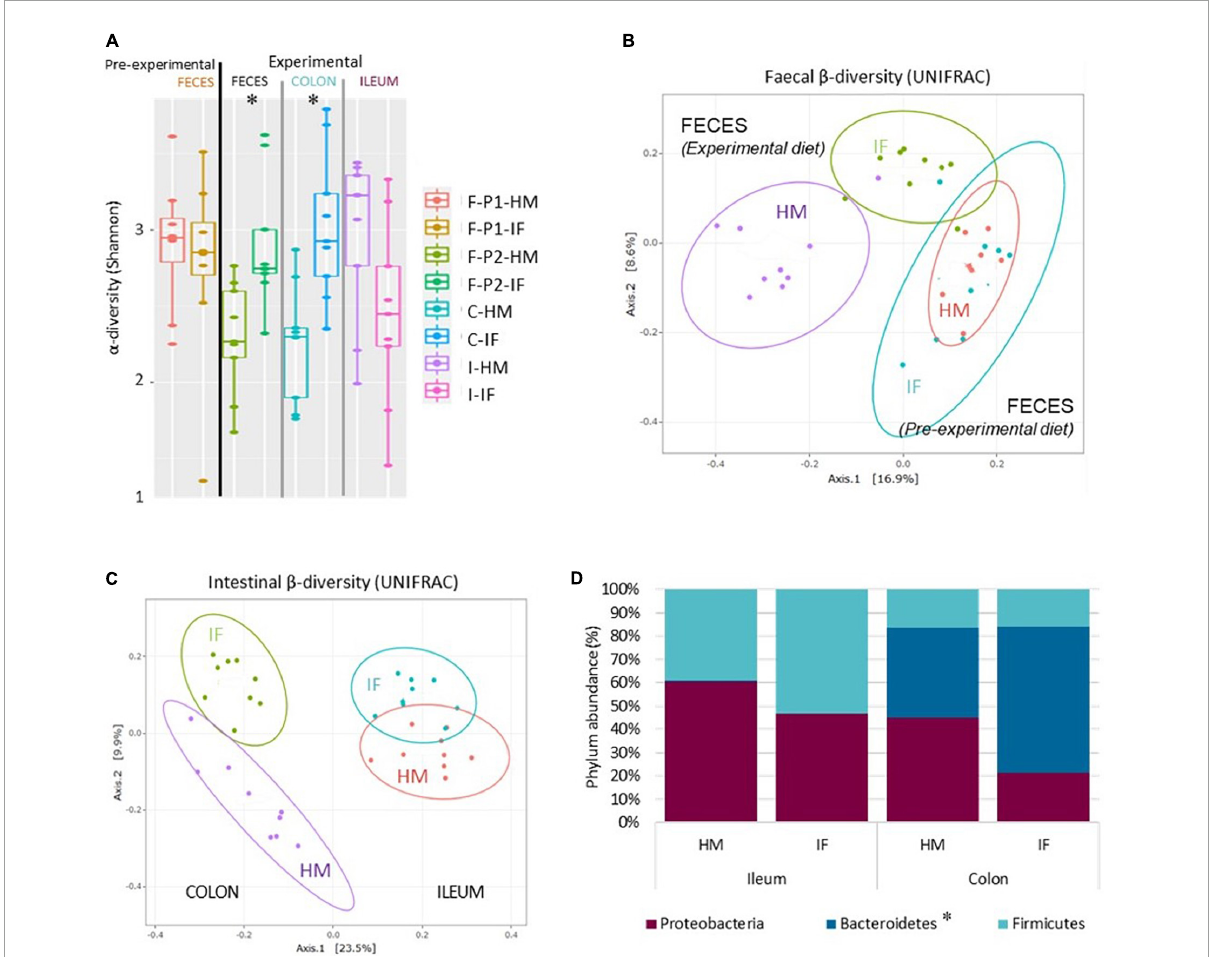
FIGURE1 Microbiota composition and diversity. (A) Microbial α -diversity (Standardized Shannon Index) in feces (F-), and colonic (C-) and ileal (I-) digesta of HM- and IF-fed piglets during the adaptation period (P1, bovine milk) and the experimental (HM or IF) period (P2). (B) Microbial fecal β -diversity (Unifrac index) of HM- and IF-fed piglets during the adaptation (blue and orange ovals) and the experimental (purple and green ovals) periods. (C) Microbial ileal and colonic β -diversity (Unifrac Index) during the experimental period. (D) Most abundant phyla in ileal and colonic digesta of HM- and IF-fed piglet (abundance > 0.05%), ∗ phylum abundance significantly different in colonic digesta of HM-fed piglets compared to IF-fed piglets, P <